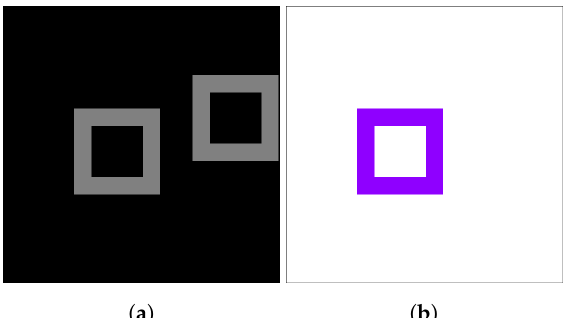
Figure 7. ( a ) Overlay of the images from sample of our toy dataset. ( b ) Ground truth optical flow.